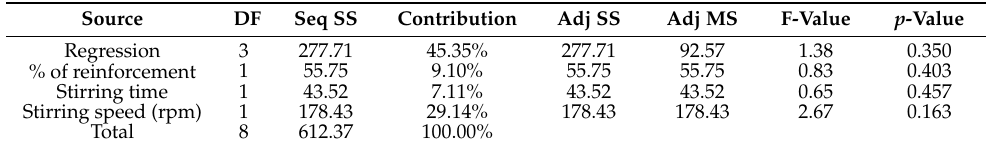
Table 13. Analysis of variance for wear